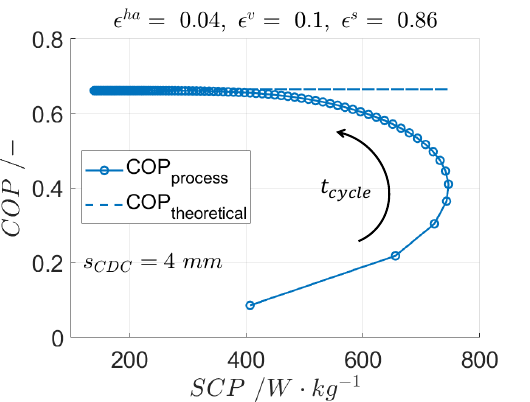
Figure 10. Pareto frontier of coefficient of performance (COP) and specific cooling power (SCP) for a constant CDC-plate layer thickness of four millimeter.